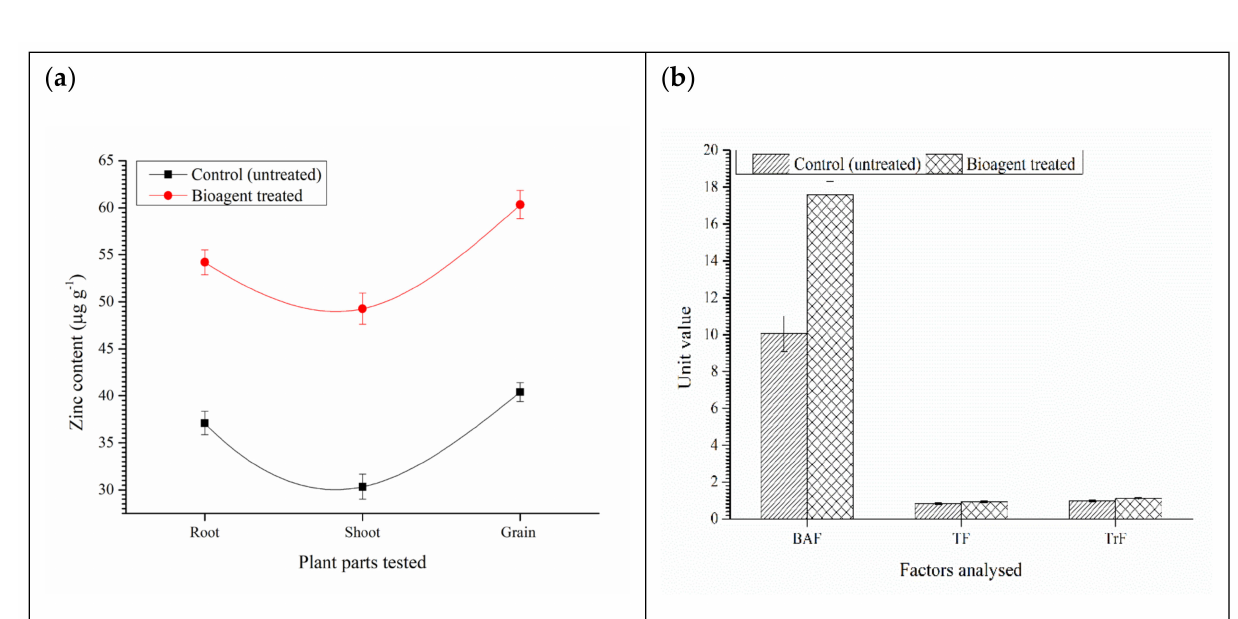
Figure 5. Effects of microbial inoculation on ( a ) Zn content in different parts of the wheat plants, and ( b ) Bioaccumulation factor, Translocation factor, and Transformation factor of the Zn in the wheat grown in saline sodic soil. Data are means and vertical bar represents standard deviation.